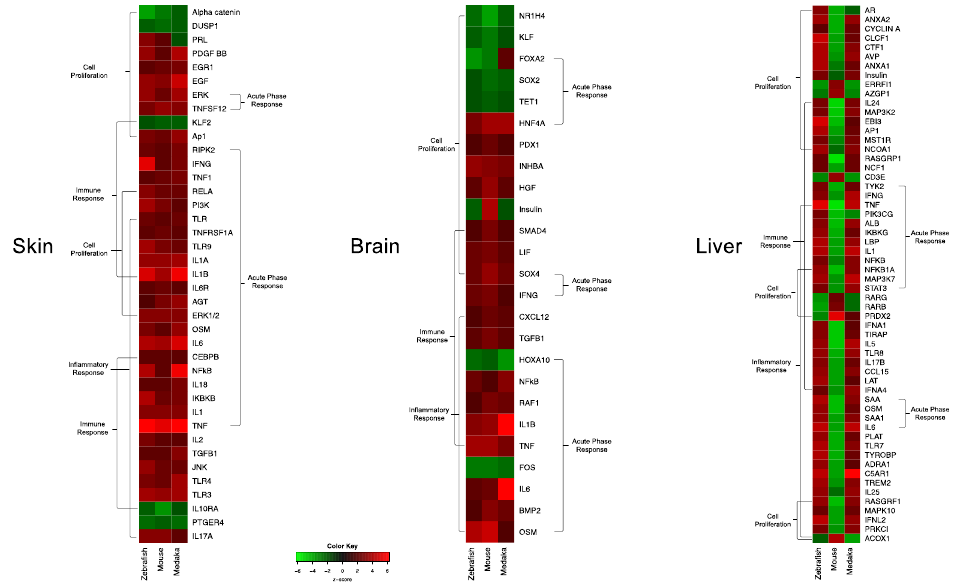
Figure 7. Zebrafish, medaka, and mouse shared up-stream regulators di ff erentially modulated (z-score ± 2) in skin (left), brain (center) and liver (right) following FL exposure. Red represents regulators that are up-modulated in response to FL, and green represents down-modulation as predicted by IPA. Medaka and mouse have one regulator in liver, PRDX2 , that is shared in the same